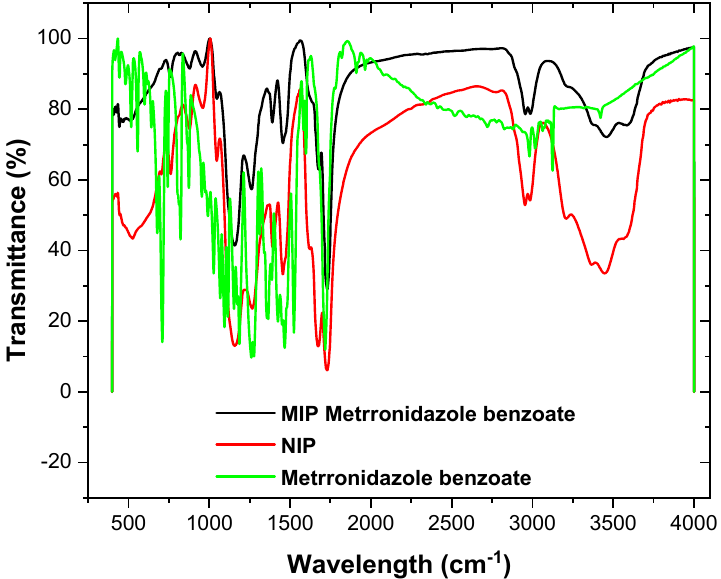
Figure 1. FT-IR spectra of the MIP, NIP, and MB drug template Figure 1. FT ‐ IR spectra of the MIP, NIP, and MB drug template materials.